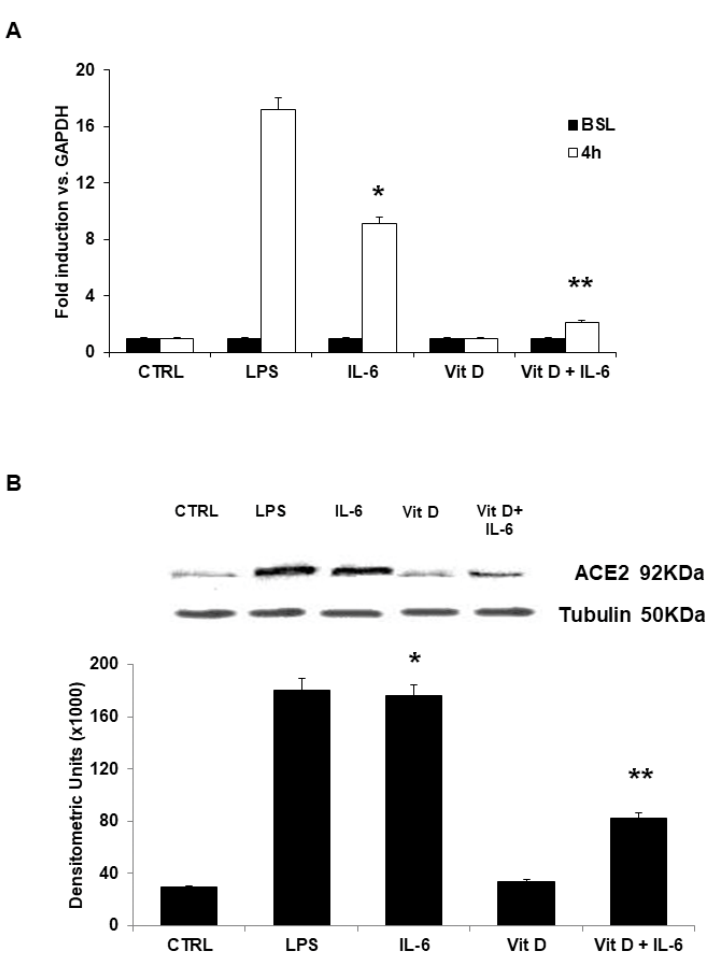
Figure 3. ( A ) Effects of VitD on IL-6-induced ACE2r transcription in human endothelial cells assessed by Real Time quantitative PCR. ACE2r mRNA was undetectable at baseline. Incubation with IL-6 caused significant increase in ACE2r mRNA levels, as compared to unstimulated cells. Preincubation with VitD inhibited the IL-6 effect on ACE2r-mRNA. LPS served as positive control. Data are expressed as fold induction versus control gene represented by GAPDH. Each bar represents the mean ± SD of 3 different experiments. (* p < 0.001 vs. Control; ** p < 0.001 vs. oxLDL; one-way ANOVA with Tukey’s post hoc test). ( B ) Effects of VitD on IL-6-induced ACE2r protein evaluated by Western blot analysis of cell lysates. IL-6 caused a significant increase of ACE2r protein levels. These effects were prevented by treatment with VitD. Tubulin served as loading control. LPS